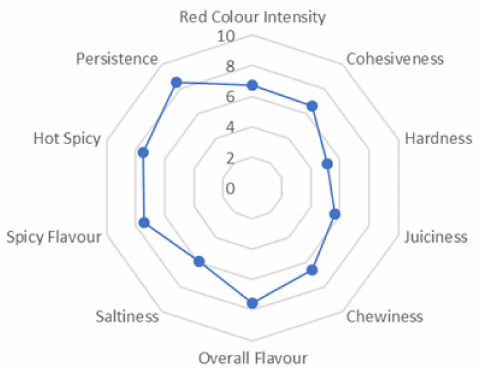
Figure 3. Results on sensory analysis from Quantitative Descriptive Analysis (QDA): the attributes are assessed within a 10-cm scale, from extremely low to extremely